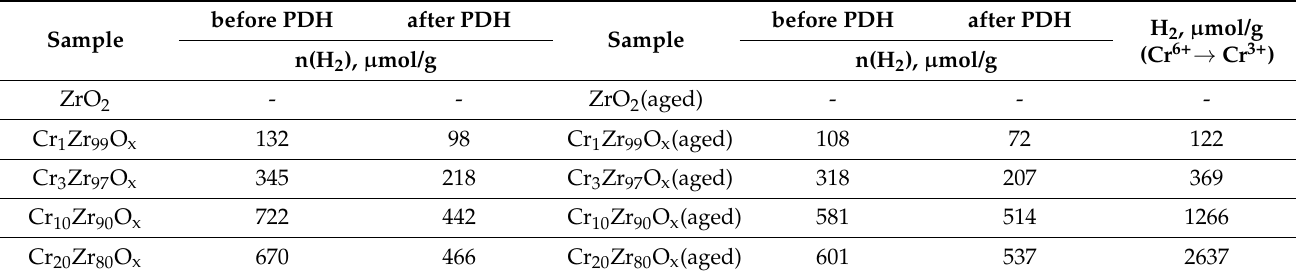
Table 3. H 2 consumption for obtained catalysts.